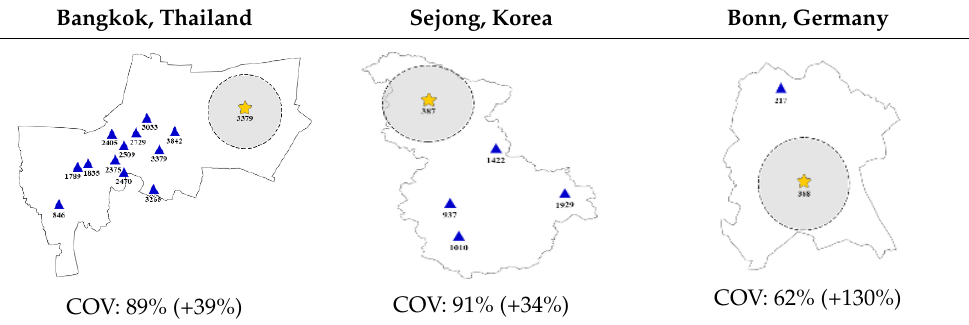
criteria. They can improve coverage percentages by 39%, 34%, and 130% in Bangkok, Sejong, and Bonn. Table 7. Location of an additional station and resulting coverage percentages in Bangkok, Sejong, and Bonn. Bangkok, Thailand